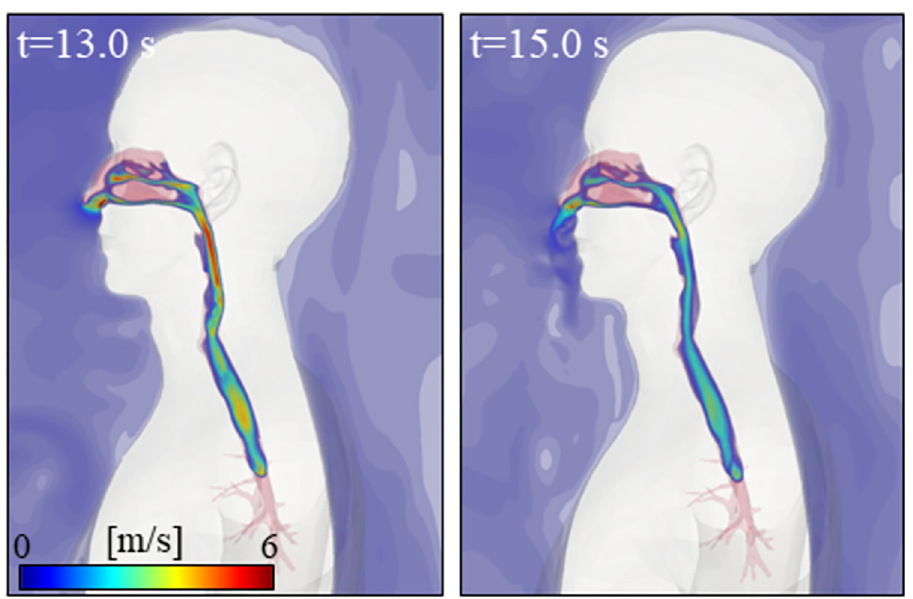
Fig 6. Instantaneous distributions of inhaled and exhaled air by Human 2 at t = 13.0 s and t = 15.0 s for C1.